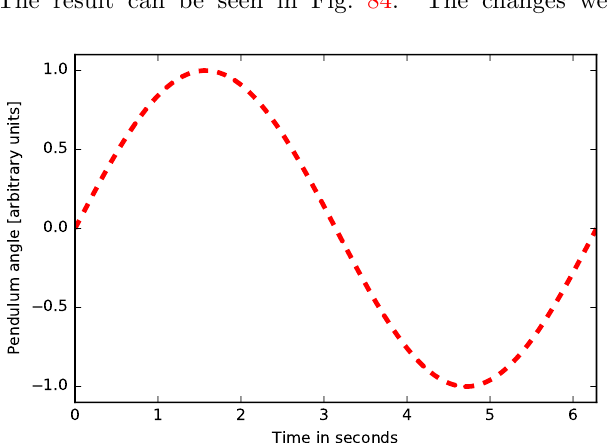
Fig. 84.— Sine curve with different color, line width, and line style have made here: specified the colour ’r’, which is red; used the “lw” for line width option to set the line width, and set the linestyle to ’dashed’ (instead of, say, ’dotted’).